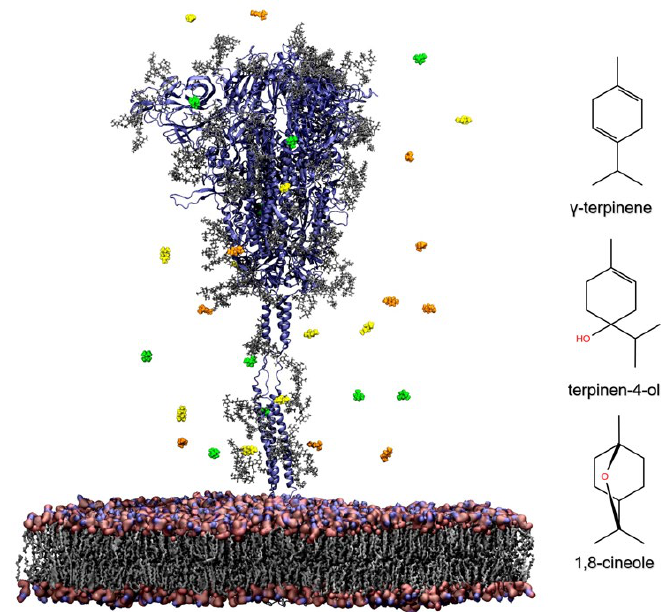
Figure 1. Overview of the simulation system. The S glycoprotein is shown as blue cartoon and the glycans as grey sticks. Membrane polar heads are shown as surface, colored by atom types, while lipid tails are represented as grey sticks. TTO compounds are shown as spheres, with γ -terpinene molecules in orange, terpinen-4-ol in yellow, and 1,8-cineole in green, and their molecular structure is represented in 2D on the right.